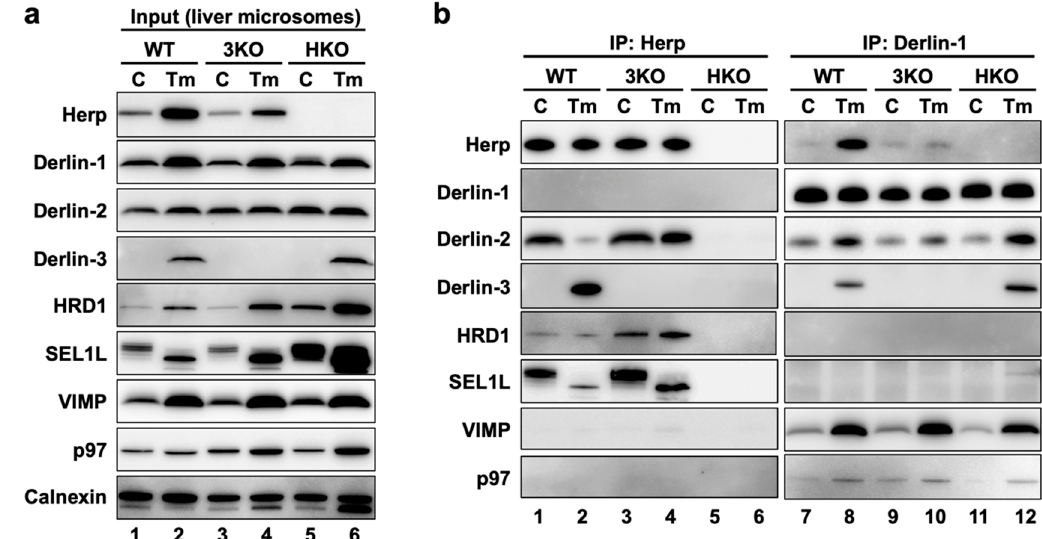
Figure 4. ERAD complexes in the mouse liver with or without ER stress. WT, 3KO, and HKO mice were intraperitoneally injected with PBS as control (C) or tunicamycin (Tm) (2-µg/g body weight) 24 h